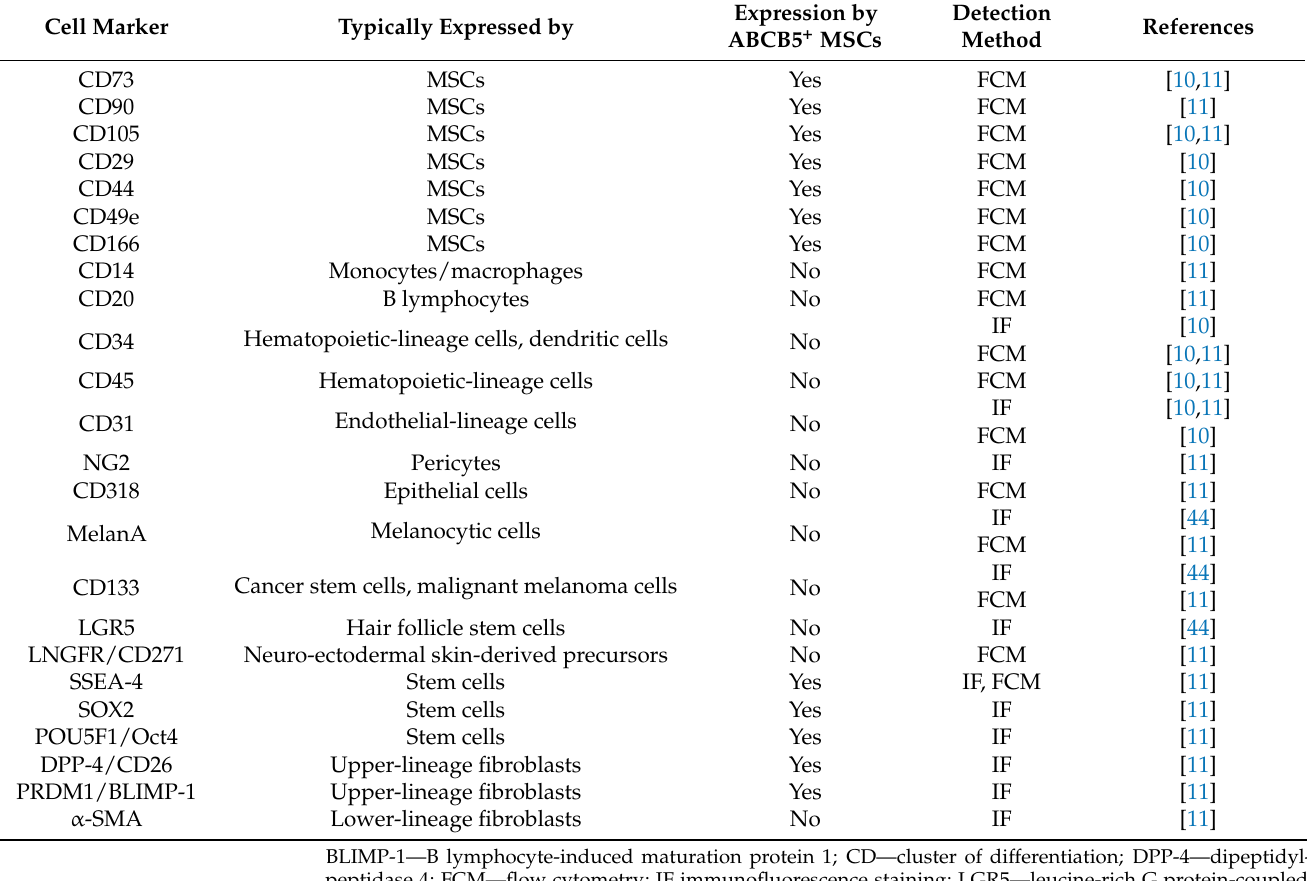
Table 2. Cell marker expression pattern of ABCB5 +